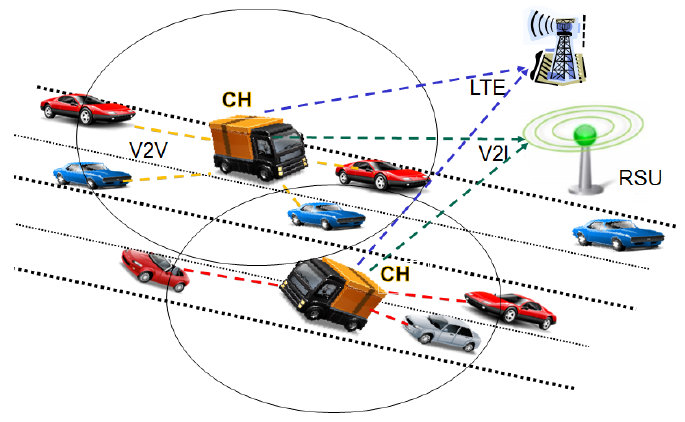
Figure 3. Clustering of